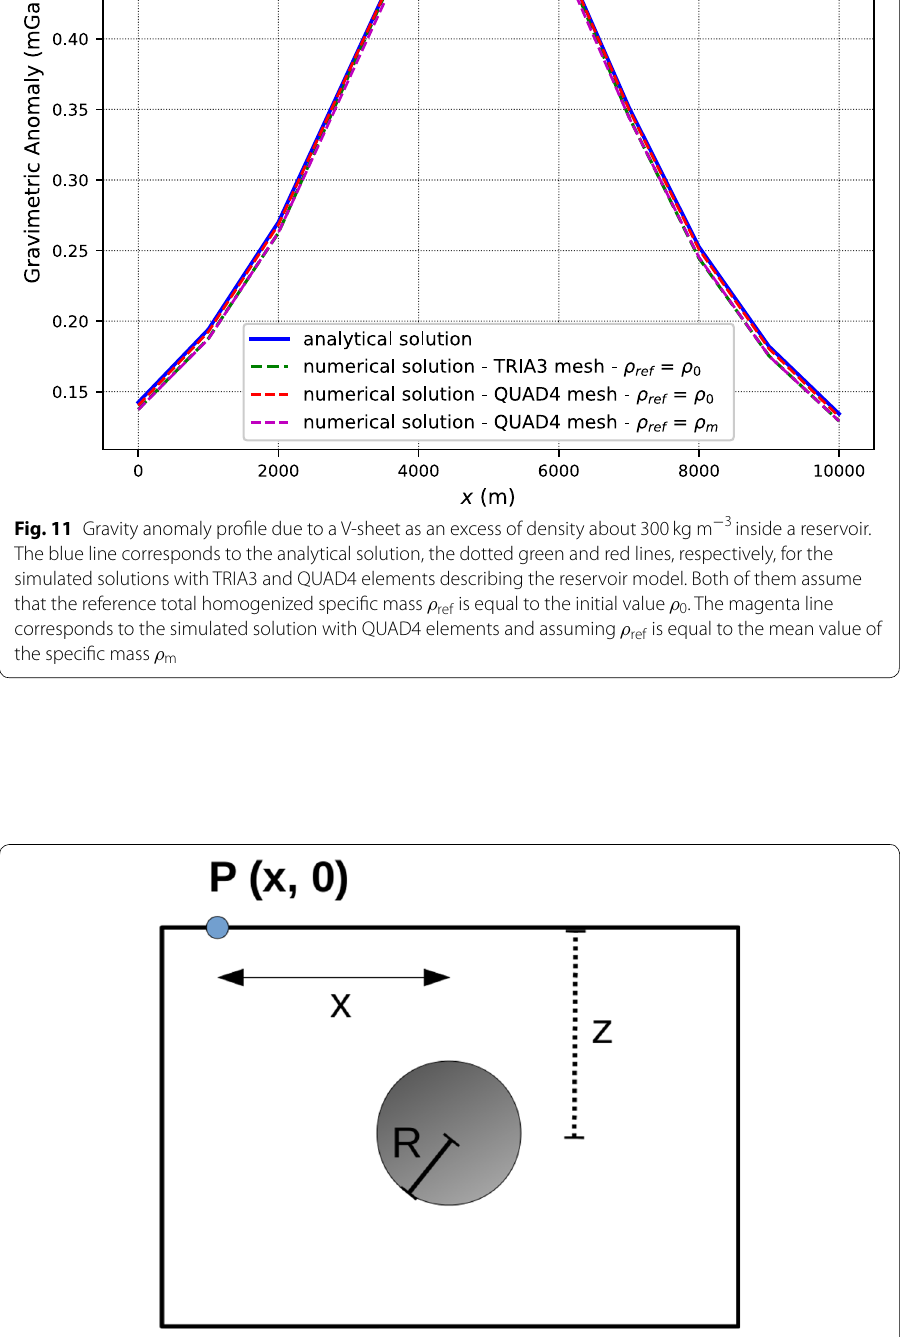
Fig. 12 Conceptual model of the geometry of the Mogi’s sphere with the radius called R and with the depth of the center called